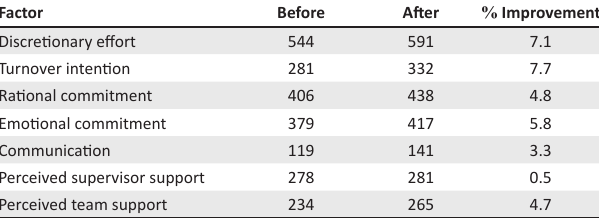
TABLE 6: Control group comparison between the two years. Factor